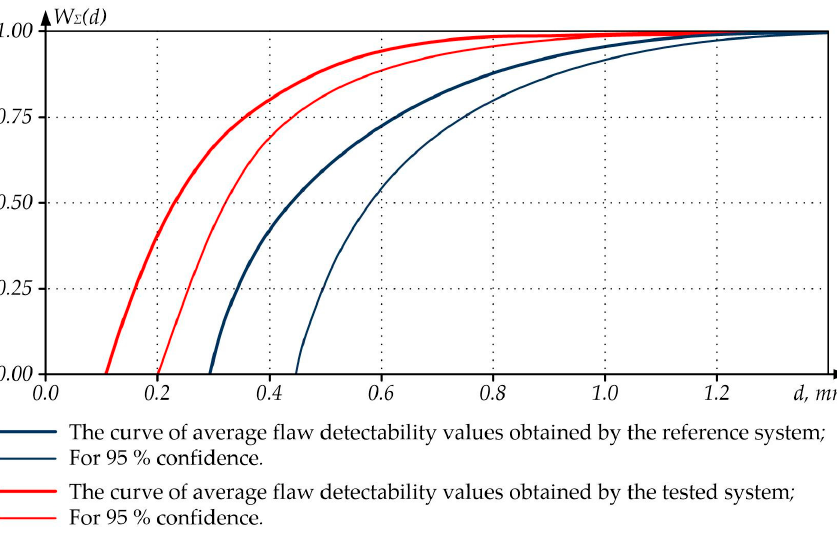
Figure 9. Curves of Flaw Detectability Depending on the Flaw Diameter.